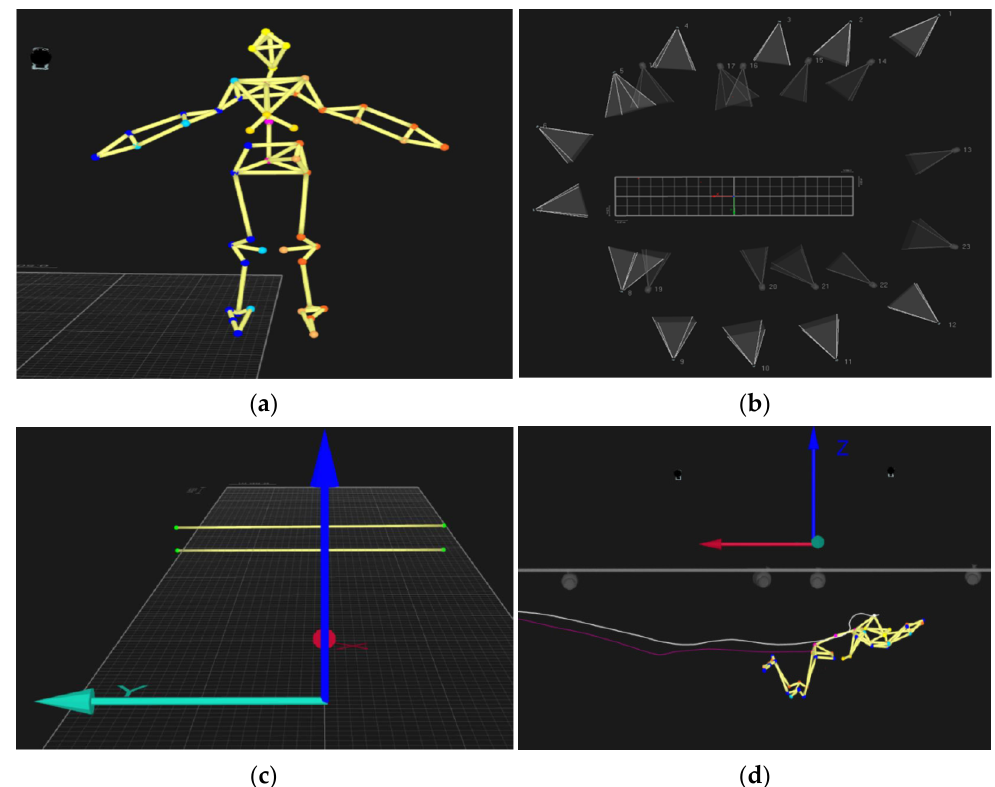
Figure 2. Kinematic data collection and data processing for ( a ) the full-body marker setup, ( b ) motion capture camera positioning, ( c ) referential system origin using four points of reflective markers and ( d ) sacrum and head kinematic traces during the pull-out phase.